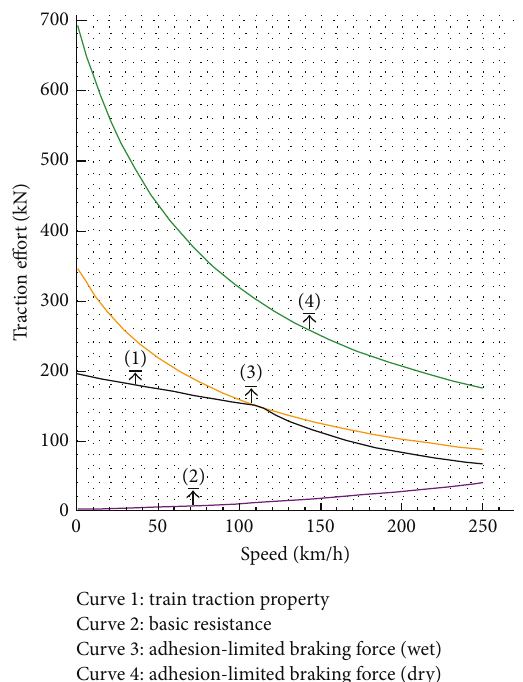
Curve 1 : train traction property Curve 2 : basic resistance Curve 3 : adhesion-limited braking force (wet) Curve 4 : adhesion-limited braking force (dry) Figure 3: Train traction property and adhesion-limited braking